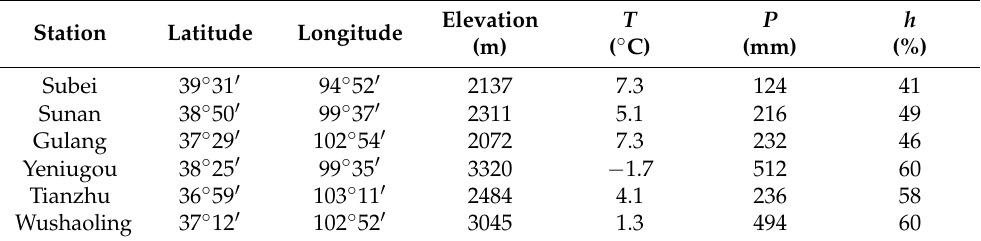
Figure 1. Location of sampling sites in the Qilian Mountains (black outline), northeastern Tibetan Plateau. The small map shows the Qilian Mountains (red outline) in the Tibetan Plateau. Table 2. Information and meteorological parameters of sampling sites during 2016–2017 (T-Air Temperature, P-Precipitation Amount and h-Relative Humidity).